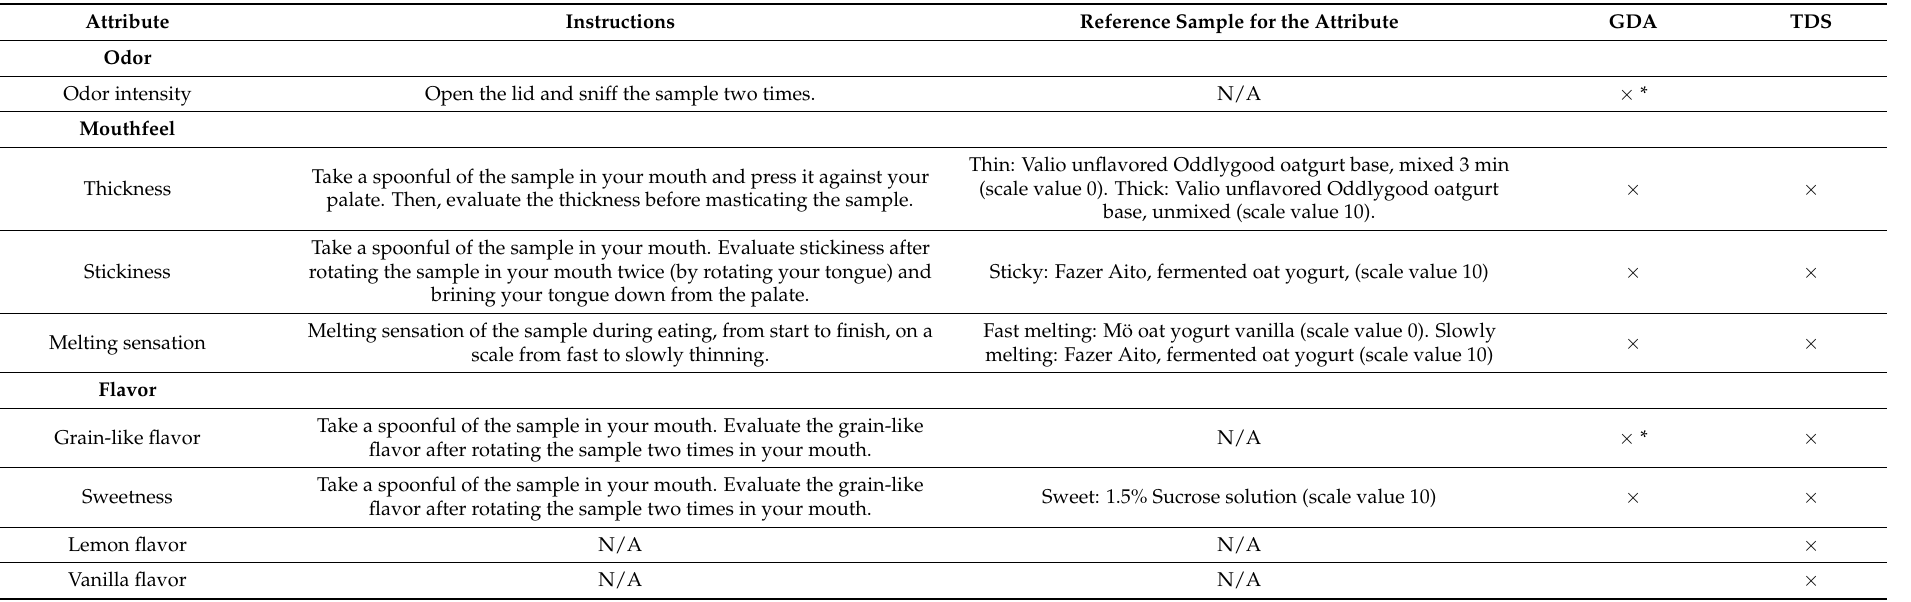
Table 2. The rated attributes in Descriptive analysis (GDA) and Temporal Dominance of sensations (TDS), evaluation instructions, and reference samples. Attribute Instructions Reference Sample for the Attribute GDA TDS Odor Odor intensity Open the lid and sniff the sample two times.